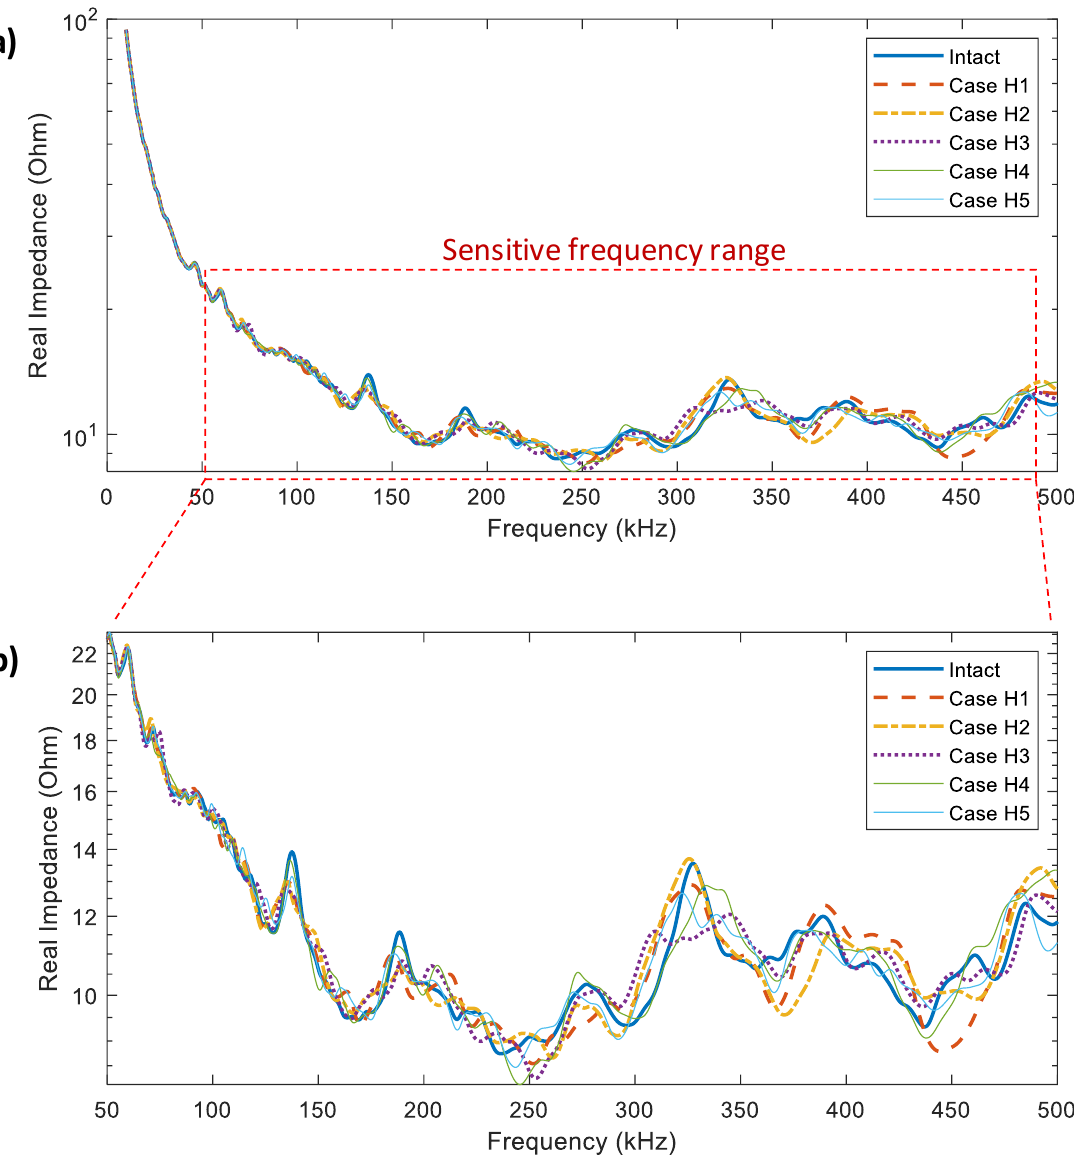
Figure 7. The EMI response of the anchorage under the intact case (not cracked) and horizontal crack cases: ( a ) Frequency range of 10–500 kHz; ( b ) sensitive frequency range of 50–500 kHz.